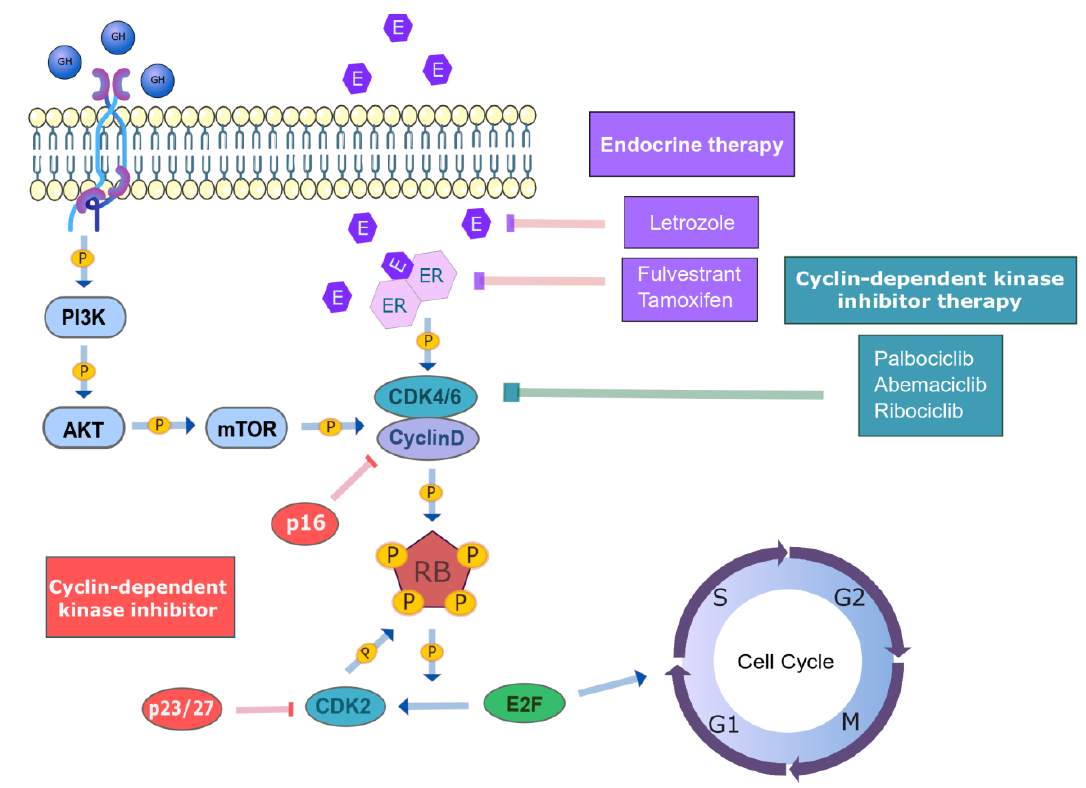
Figure 1. Regulation of the cell cycle in HR+/HER2- mBC patients. The regulation of the cell cycle is mediated by the CCND1–CDK4/6-RB axis. The CCND1–CDK4/6 complex phosphorylates the RB protein, which releases E2F transcription factors. The latter lead to the G1/S transition of the cell cycle. The cyclin–CDK complexes are, in turn, regulated by other cyclins or intrinsic CDK inhibitors (INK4 and CIP/KIP family members) (in red). The current treatments in HR + mBC are endocrine therapy (in purple) and CDK inhibitors (in green). (HR: hormone receptor, HER2: human epithelial growth factor receptor 2, CCND1: cyclin D1, CDK4/6: cyclin-dependent kinase 4/6, RB: retinoblastoma, E2F: E2F transcription factor, CDK inhibitors: cyclin-dependent kinase inhibitors, INK4: inhibitors of CDK4, CIP/KIP: CDK interacting protein/kinase inhibitory protein).